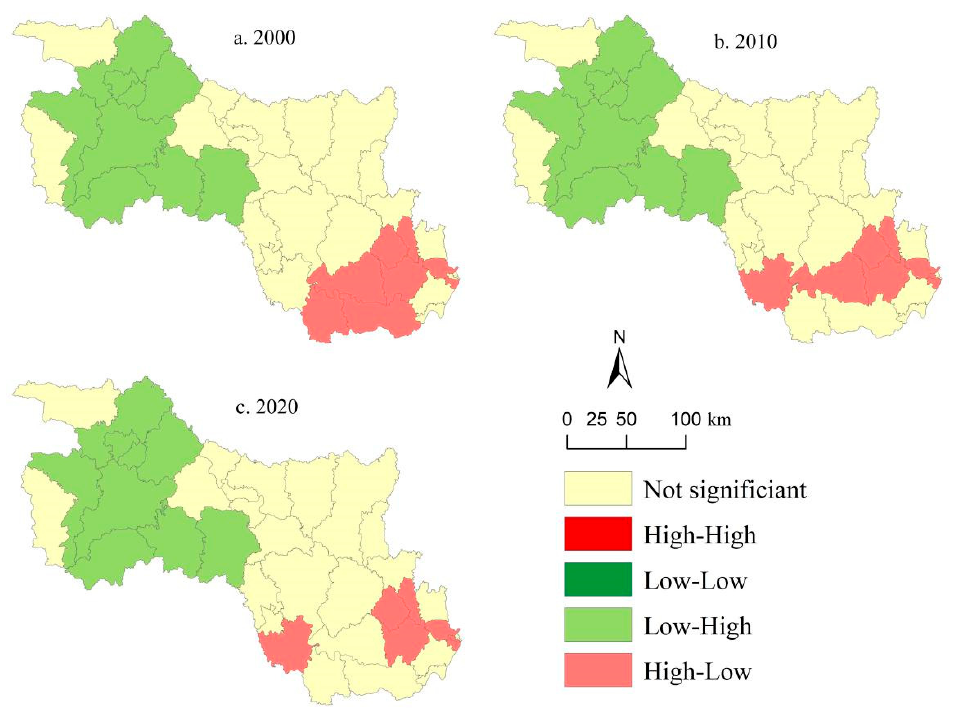
Figure 7. Moran scatter plots of land use intensity with ESV in the HRB of Hubei Province for ( a ) 2000, ( b ) 2010, and ( c ) 2020.